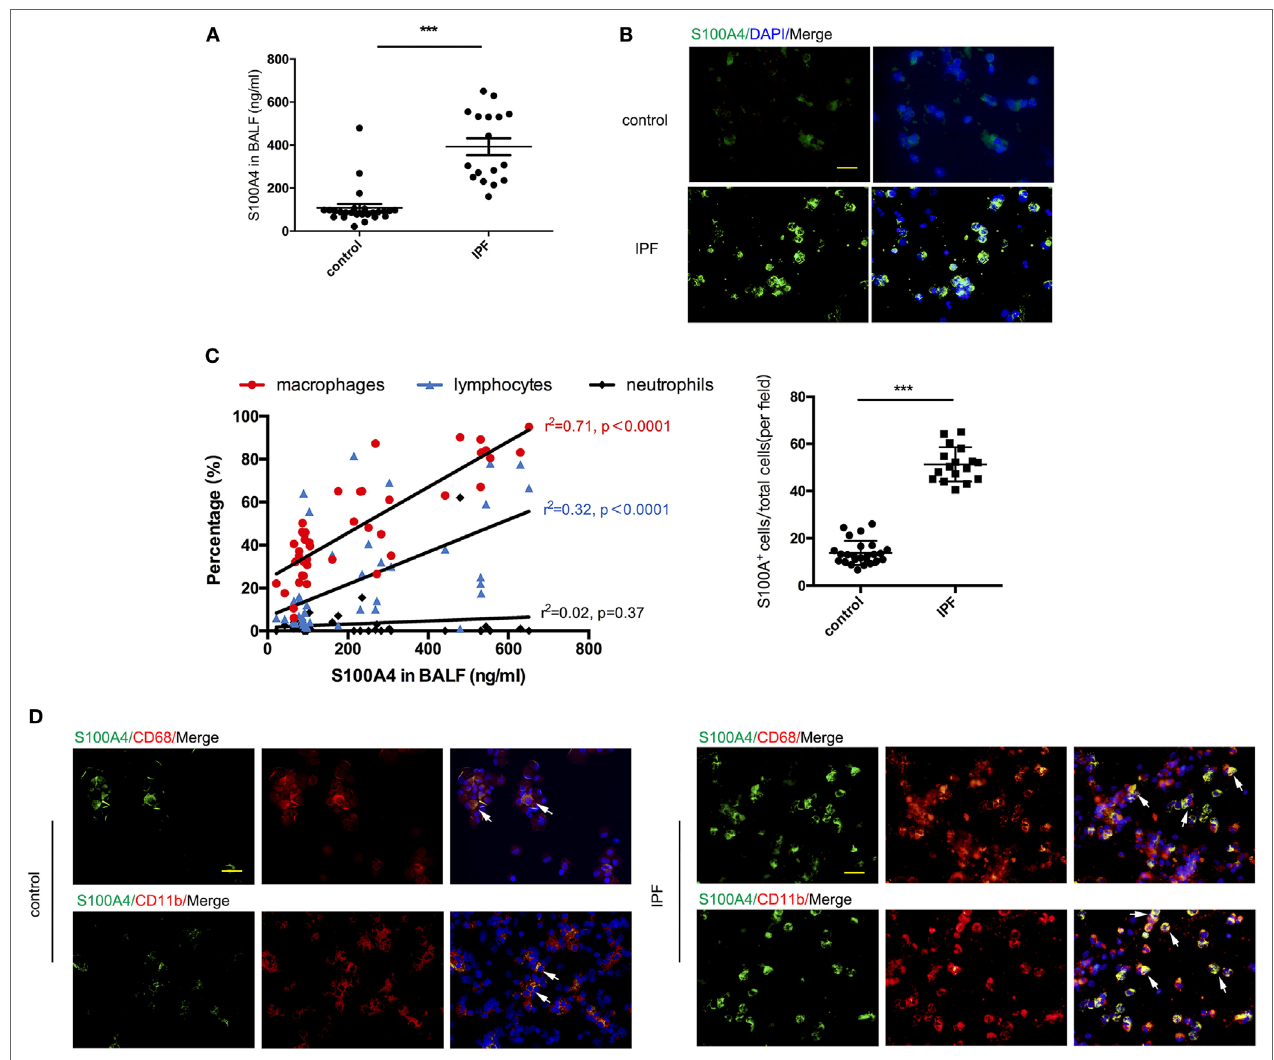
FigUre 1 | Extracellular S100A4 or S100A4 + cells are increased in bronchoalveolar lavage fluid (BALF) of idiopathic pulmonary fibrosis (IPF) patients. Soluble and cell-associated S100A4 was assessed from the BALF of patients with IPF ( n = 17) or non-IPF lung disease ( n = 25). (a) Levels of soluble S100A4 protein detected by enzyme-linked immunosorbent assay. Mean ± SEM, *** p < 0.001, Mann–Whitney. (B) S100A4 (green) in cells from BALF smears was visualized by immunofluorescence (upper panel). S100A4 + cells of total cells in each field were shown (lower panel), *** p < 0.001, Mann–Whitney. (c) S100A4 concentrations in BALF were correlated with percentages of macrophages, lymphocytes, or neutrophils as determined by cytology from H&E-stained BALF smears. Fits for each cell type indicated by the correlation coefficient “ r ” from Pearson test. (D) S100A4 (green) in combination with CD68 (red; upper panel) or CD11b (red; lower panel) in cells from BALF smears of IPF or non-IPF lung disease donors. (B,D) Representative images for each patient group, nuclei counterstained with 4 ′ ,6-diamidino-2-phenylindole (DAPI) (blue), scale bars, 25